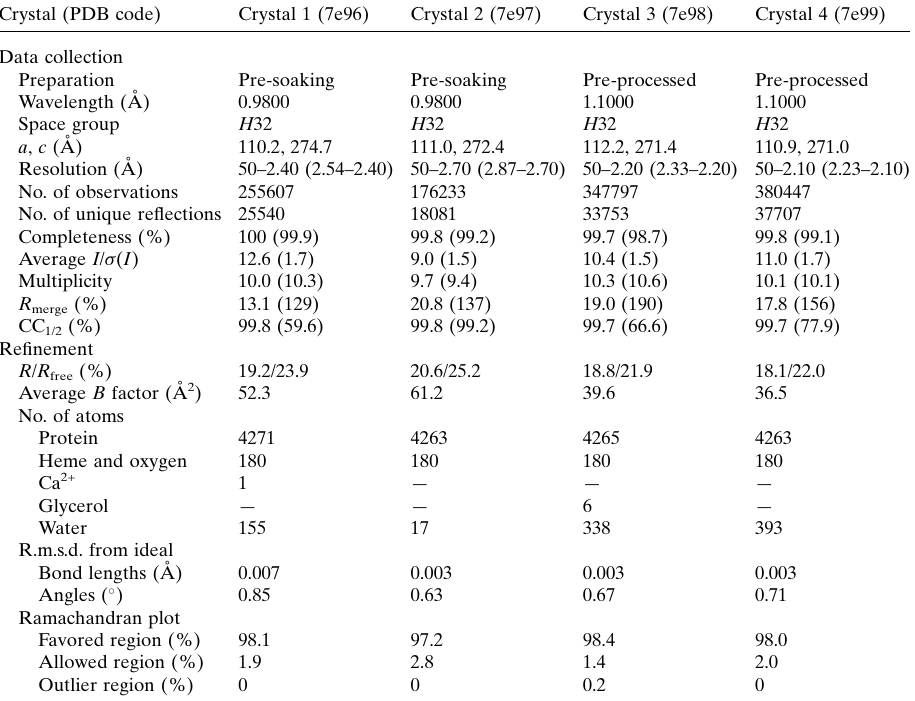
Table 1 Data-collection and refinement statistics. Values in parentheses are for the highest resolution